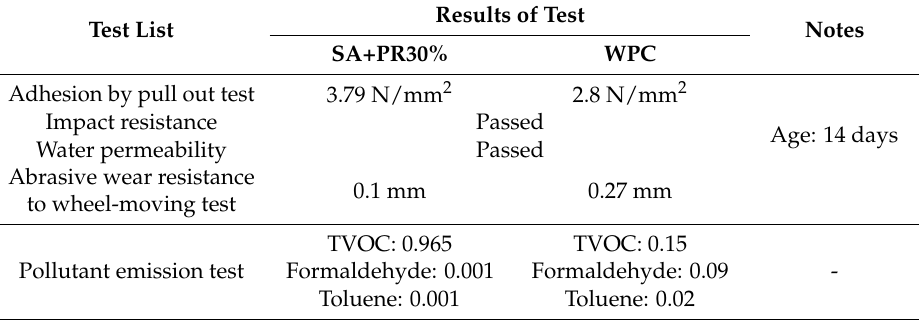
Table 9. Comparative values of test